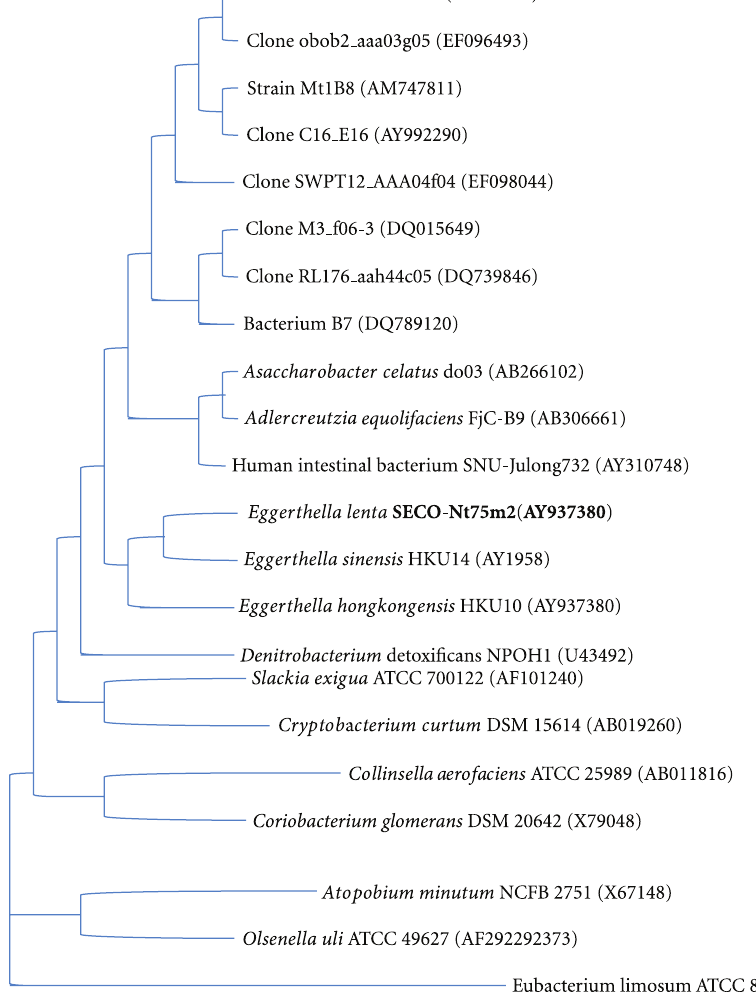
Figure 2: Phylogenetic position of strain Eggerthella lenta SECO-Mt75m2 among members of the family Coriobacteriaceae based on 16S RNA sequencing. Adapted with permission from Clavel et al.